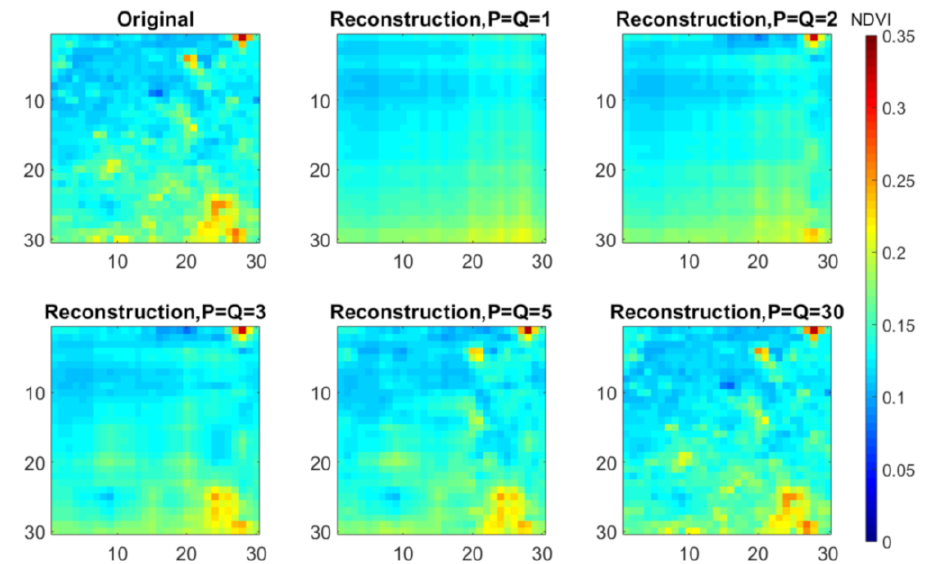
Figure 7. Tucker model reconstructions for a single time frame shown for different ranks in the spatial modes ( P , Q ). The tensor that was decomposed here consisted of 30 identical 30 × 30 frames (SIM1). The reconstruction becomes more accurate as the ranks in both spatial modes are